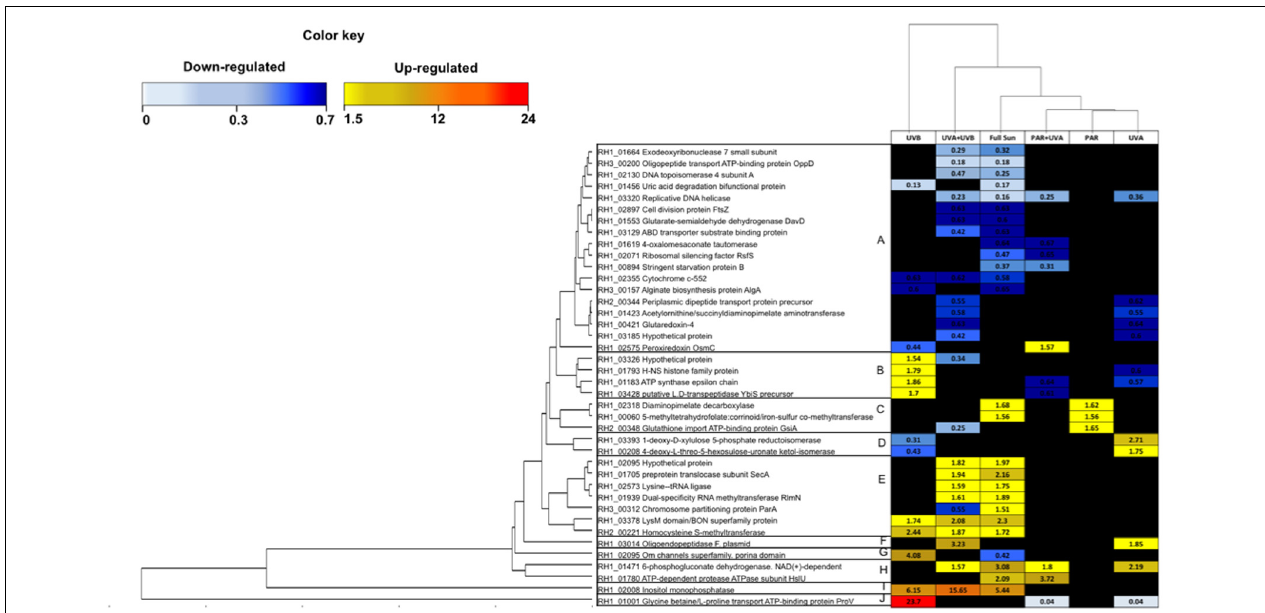
FIGURE 5 | Heat-map showing 40 differentially regulated proteins shared between at least two treatments among the 6 Natural light conditions (Full Sun, PAR, PAR+UVA, UVA+UVB, UVA, UVB). Each cell of the grid was colored based on increased and decreased abundance above 1.5 or below 0.66,